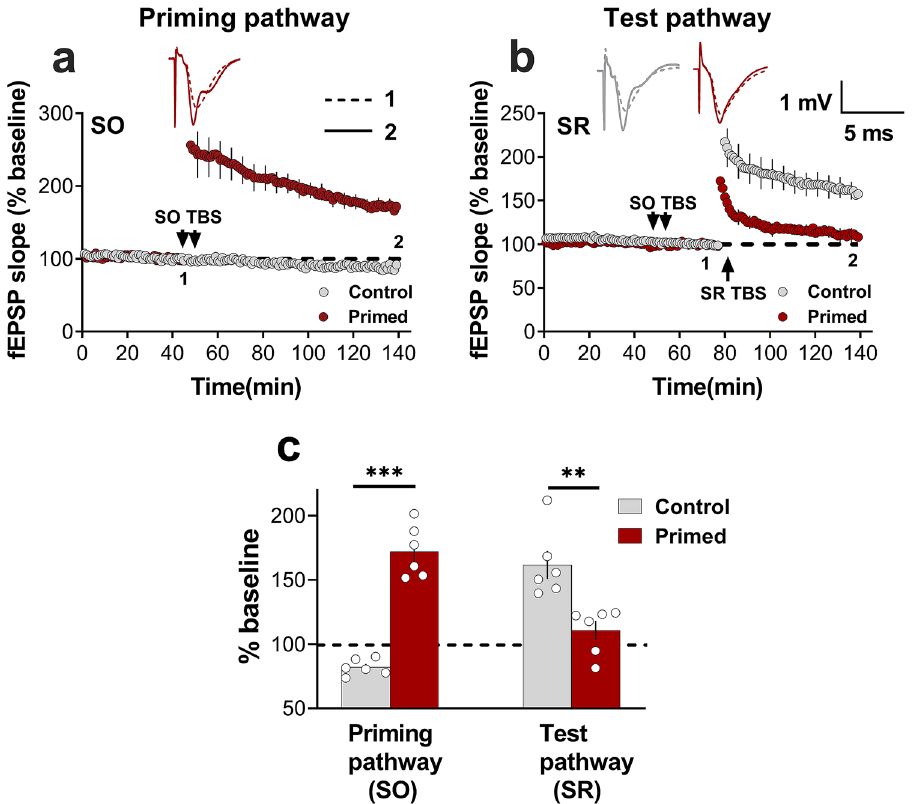
(Control = 161.5 ± 8%, n = 6; Primed = 110.7 ± 3%, n = 6; t (10) = 3.86, p = 0.003). ( c ) Bar graph summarising the TBS-induced homosynaptic LTP in SO and inhibition of LTP in SR. ** , p < 0.01; *** , p <